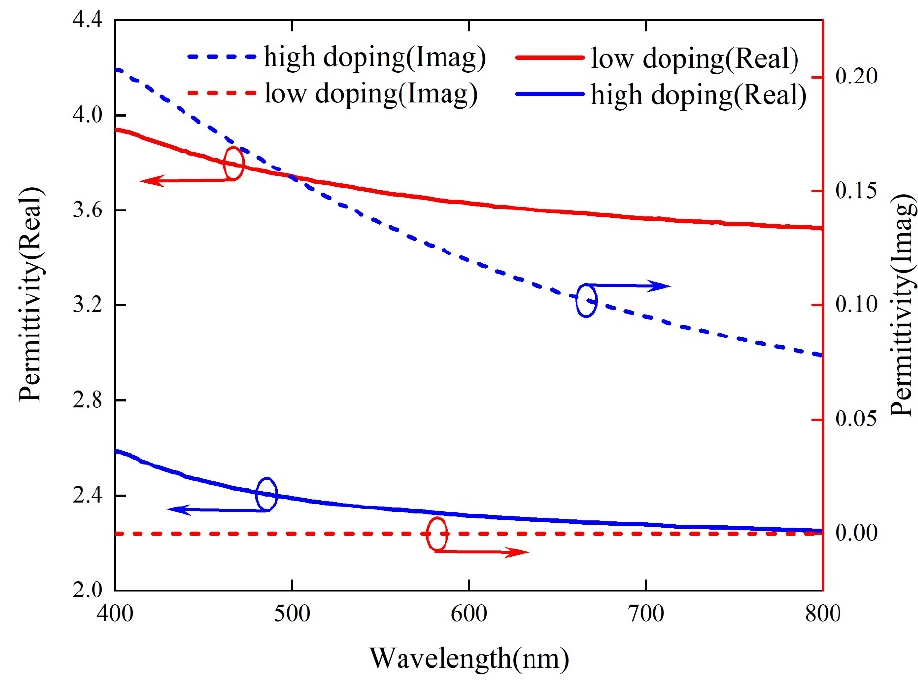
Figure 1. The real and imaginary parts of the complex dielectric constant of IGZO vary with wavelength. The designed color-changing filter which involves inserting IGZO between the two metal layers, is shown in Figure 2a. Ag was selected as the metal reflector, as it has high reflectivity in the visible light range. Its refractive index was obtained from the literature [38]. For the scale parameters, the thickness of the top and bottom Ag was t = 30 nm, the thickness of the middle IGZO was d and the substrate was SiC. In the absence of free carriers, the optical properties of SiC are given by the Drude–Lorentz model [39]: